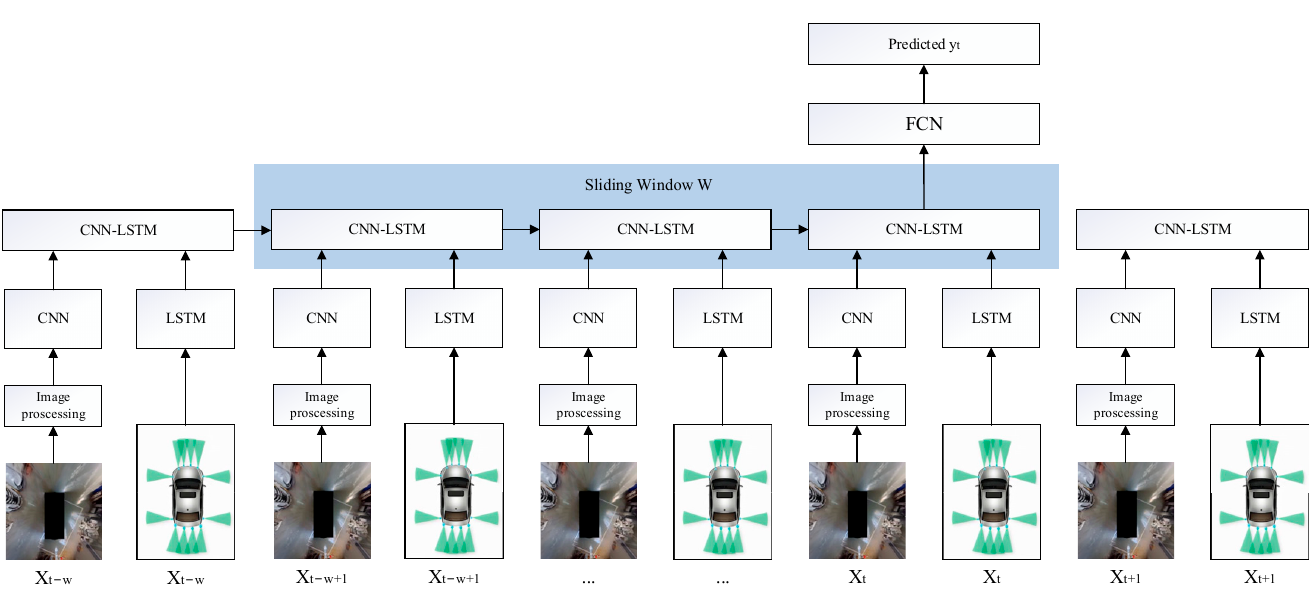
Figure 10. Schematic diagram of the model training process.